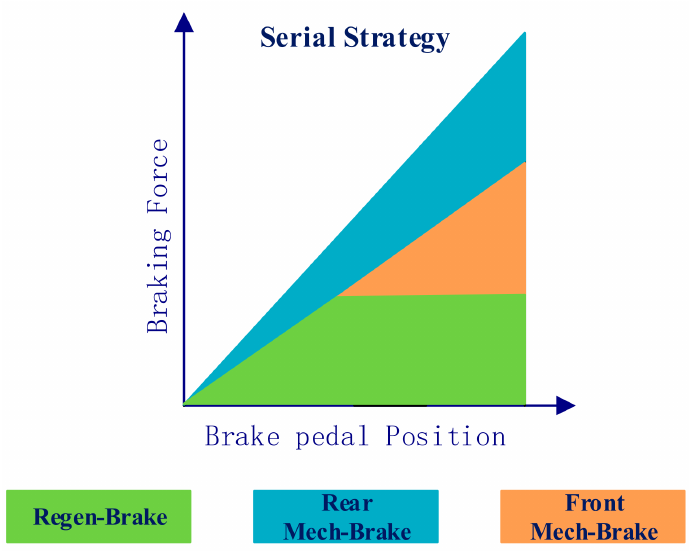
Figure 10. Braking force distribution of serial strategy.